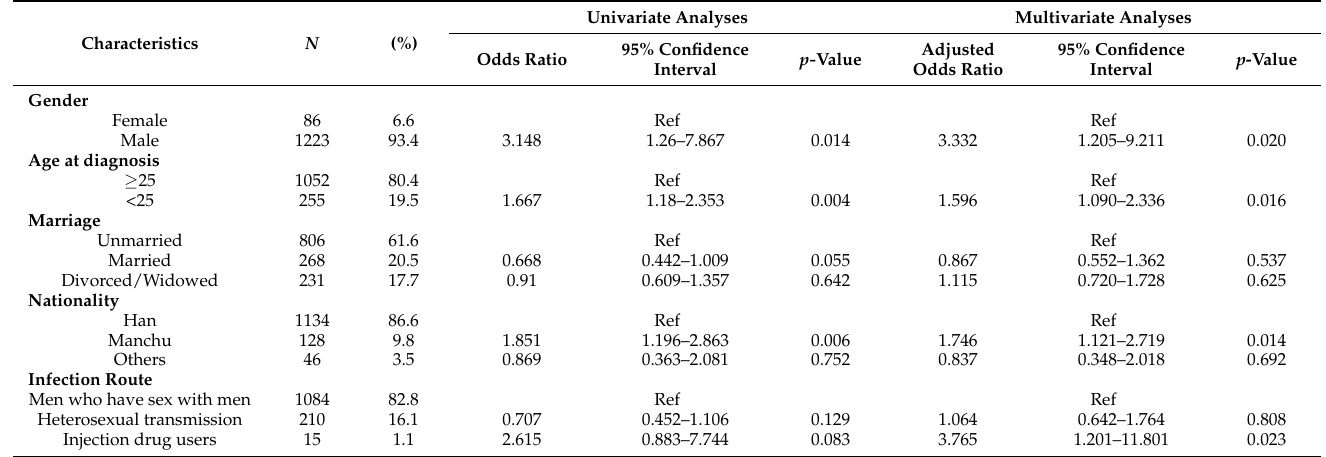
Table 2. Characteristics of undiagnosed HIV-infected